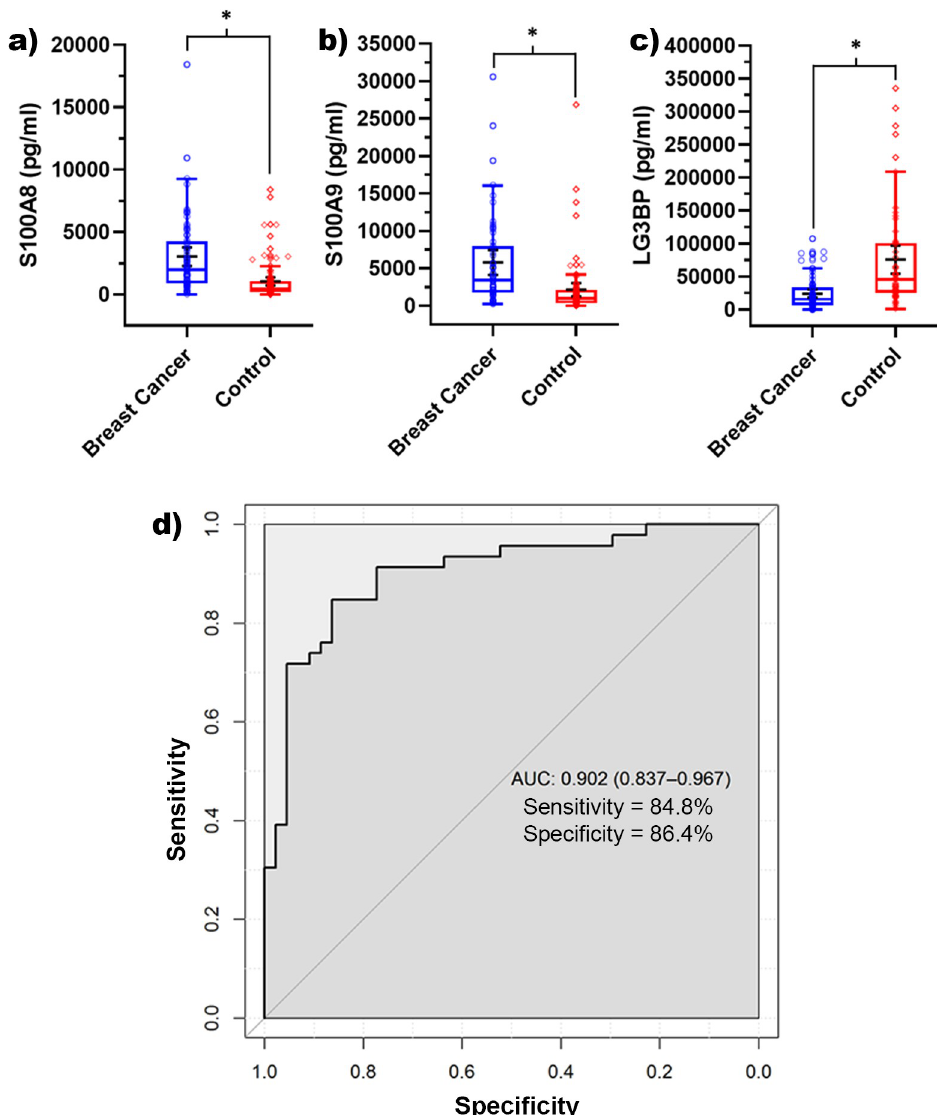
Fig 2. Investigation of biomarkers by ELISA- a) S100A8, b) S100A9, and c) LG3BP expression levels in tear samples between healthy and breast cancer women. (n = 96 control and 75 breast cancer samples, � indicates p < 0.0001); d) Receiver Operating Characteristics (ROC) curve for protein expression of potential breast cancer biomarkers. The area under the ROC curve (AUC) represents the accuracy of the combined potential biomarkers for distinguishing between the control and breast cancer sample